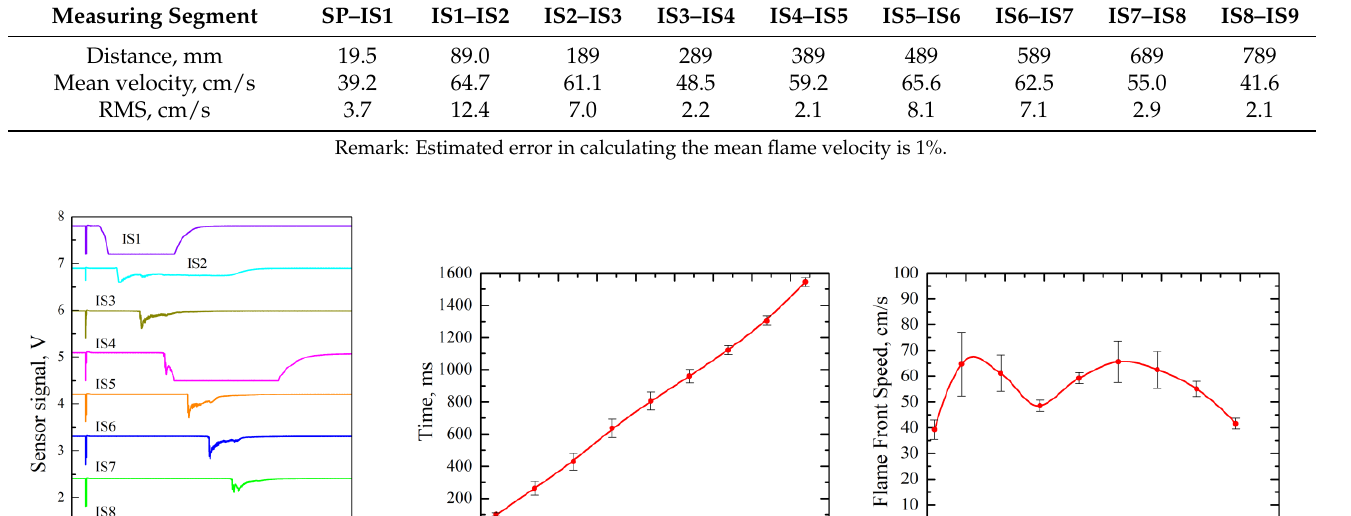
Table 4. Mean flame velocities at measuring segments.